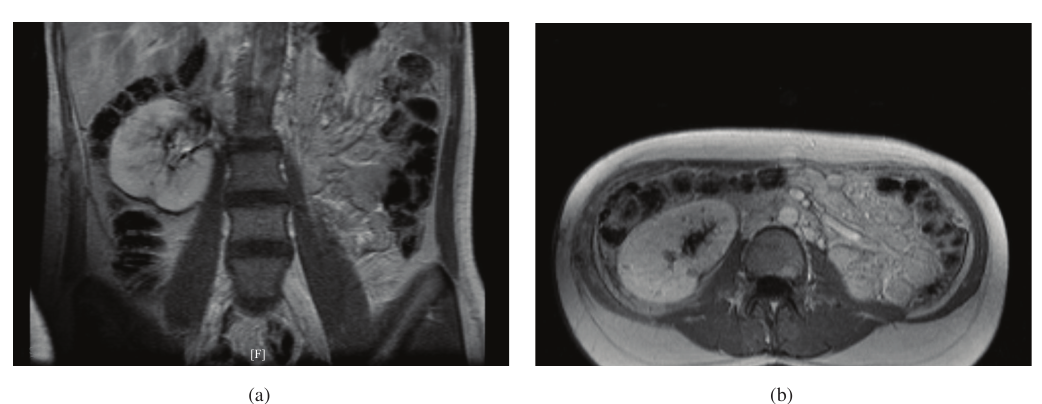
FIGURE 3: MRI showing the right kidney 2 months after kidney-sparing conservative surgery. (a) Coronal appearance of the right kidney. (b) Axial appearance of the right kidney. Good kidney preservation was